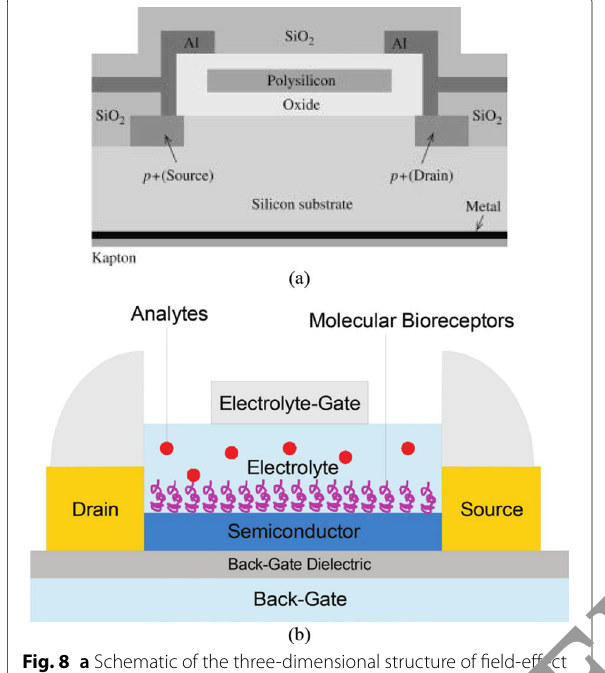
Fig. 8 a Schematic of the three-dimensional structure of field-effect transistors based on p-type semiconductors. b Schematic of the two-dimensional structure of field-effect transistors and the potentials applied to it